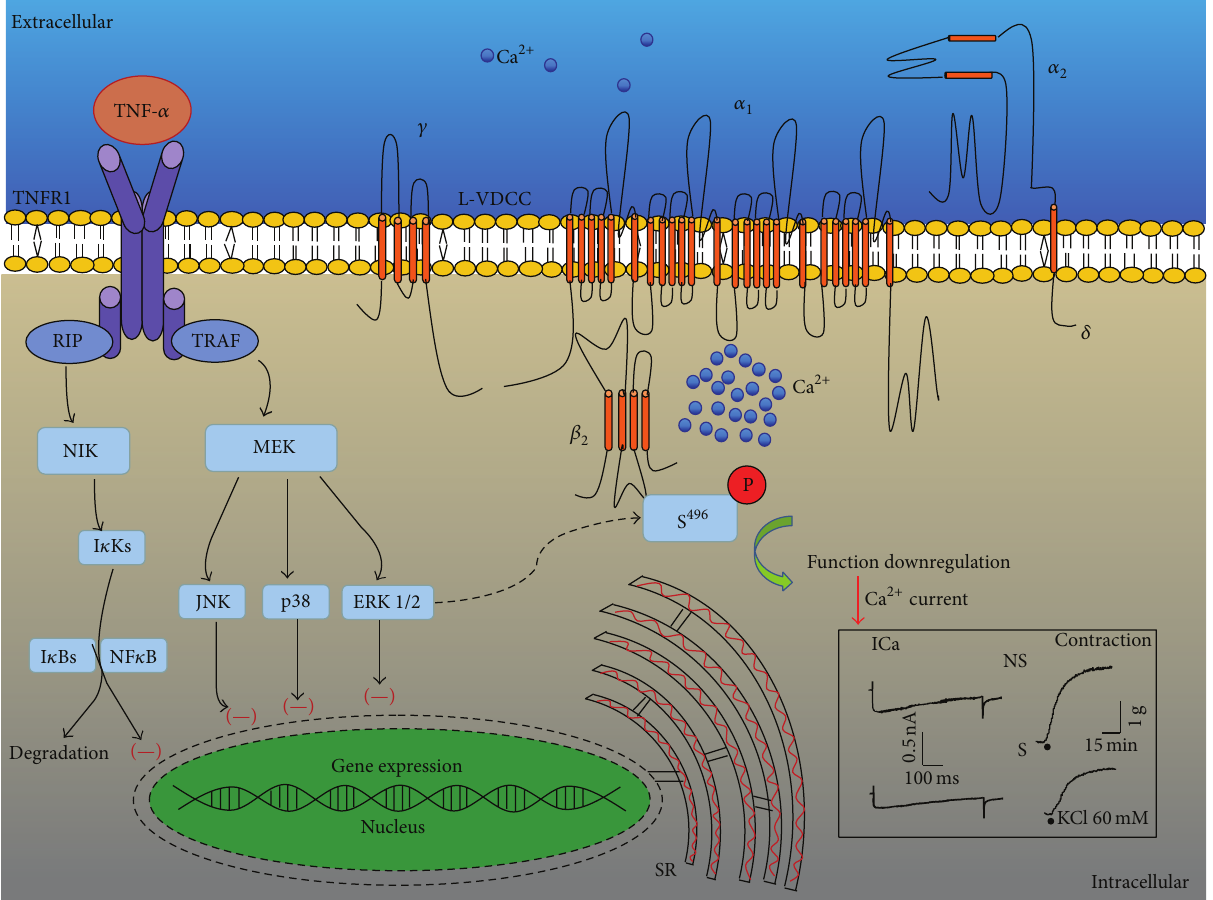
Figure 8: Schematic representation of the proposed mode of action of tumor necrosis factor 𝛼 (TNF- 𝛼 ) on the L-type voltage dependent calcium channel (L-VDCC) of the guinea pig airway smooth muscle. TNF- 𝛼 whether exogenous or present in sensitized guinea pig serum (Ser-S) activates its receptor 1 (TNFR1). Afterwards, it promotes synthetic signaling pathways: it activates receptor interacting protein (RIP), NF- 𝜅 B-inducing kinase (NIK), and I 𝜅 B kinases (I 𝜅 Ks) that phosphorylate NF 𝜅 B inhibitors (I 𝜅 Bs) activating nuclear factor 𝜅 B (NF 𝜅 B) and through TNF receptor-associated factor (TRAF), map kinase kinase (MEK) and extracellular signal-regulated kinase (ERK 1/2), p38 MAPK, or c-Jun N-terminal kinase (JNK). We demonstrated that a synthetic pathway was not responsible for the diminution in the Ca 2+ current (ICa, see Figure 4). Nevertheless, ERK 1/2 might be directly phosphorylating serine 496 ( S 496 ) on the 𝛽 2 subunit of the L-VDCC, favoring a downregulation of the ICa. Inset illustrates ICa in tracheal myocytes and contraction in tracheal rings from guinea pigs. NS implies nonsensitized tissues or cells and this indicates the absence of exogenous TNF- 𝛼 or serum from Ser-S. S illustrates original recordings from sensitized tissues or cells in the presence of Ser-S; notice that both ICa and contraction are diminished. Other subunits of the L-VDCC: 𝛼 1 , 𝛾 , 𝛿 . SR: sarcoplasmic 𝛼 2 ,